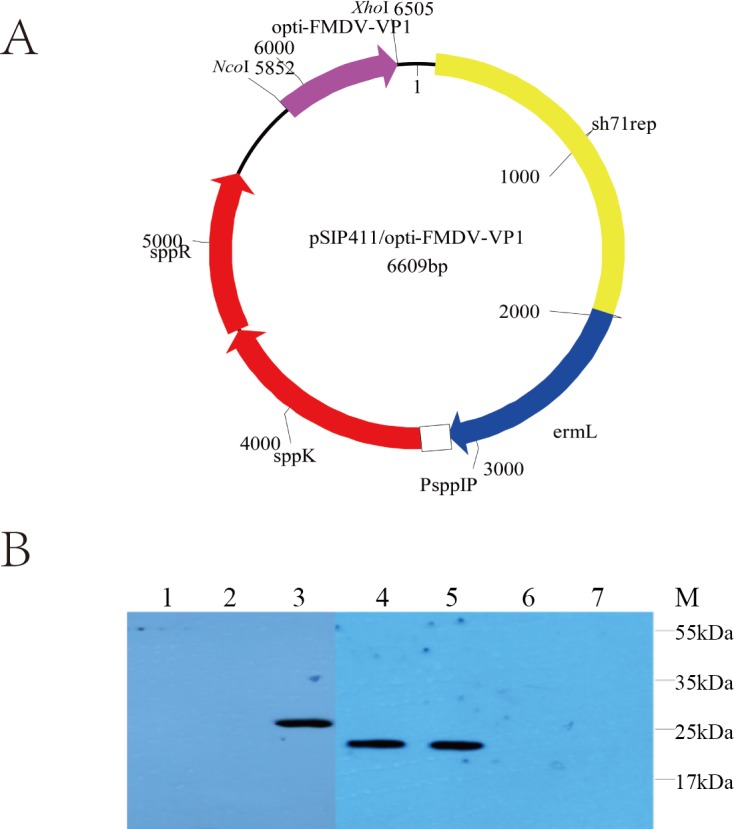
Plasmids for the expression of recombinant VP1 antigen and western blotting of expressed WCFS1-pSIP411-VP1 and NC8-pSIP411-VP1 proteins.(A) The pSIP411-VP1 plasmid was constructed as described in the article and the purple arrow stands for optimized VP1. (B) The VP1 proteins expressed in WCFS1-pSIP411-VP1 and NC8-pSIP411-VP1 were detected by western blotting. Lane 1: WCFS1-pSIP411 induced by SppIP; Lane 2: WCFS1-pSIP411-VP1 without inducer; Lane 3: WCFS1-pSIP411-VP1 induced by SppIP; Lane 4: NC8-pSIP411-VP1 induced by SppIP; Lane 5: FMDV as positive control; Lane 6: NC8-pSIP411-VP1 without inducer.; Lane 7: NC8-pSIP411 induced by SppIP. Abbreviations: sh71rep: replication origin for lactobacillus; ermL: erythromycin-resistance marker; PsppIP: inducible promoters; sppK: histidine protein kinase; sppR: response regulator.